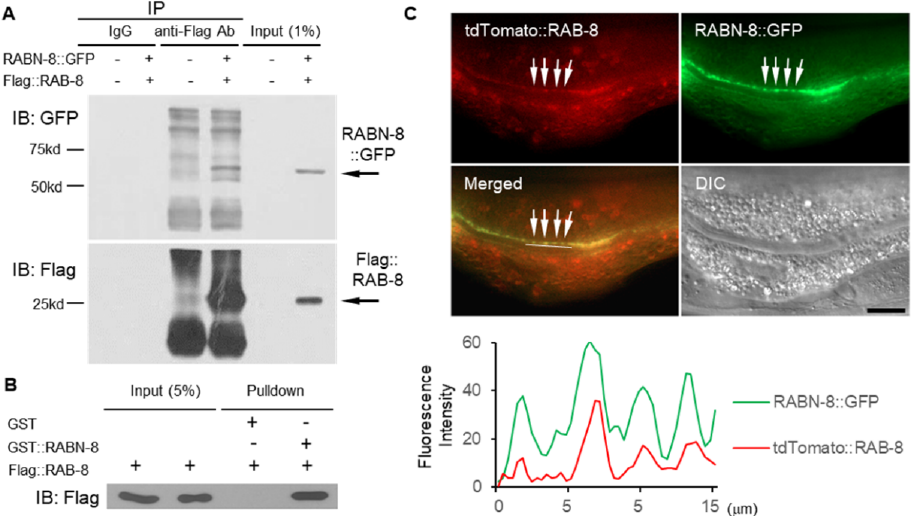
Figure 4. Direct interaction and colocalization of RAB-8 and RABN-8. ( A ) HEK293 cells